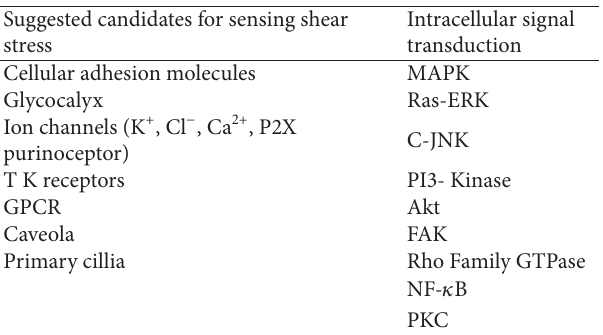
Table2:Suggestedshearstresssensingmechanismsbytheendothe- lial cells and related intracellular signal transductions [33,